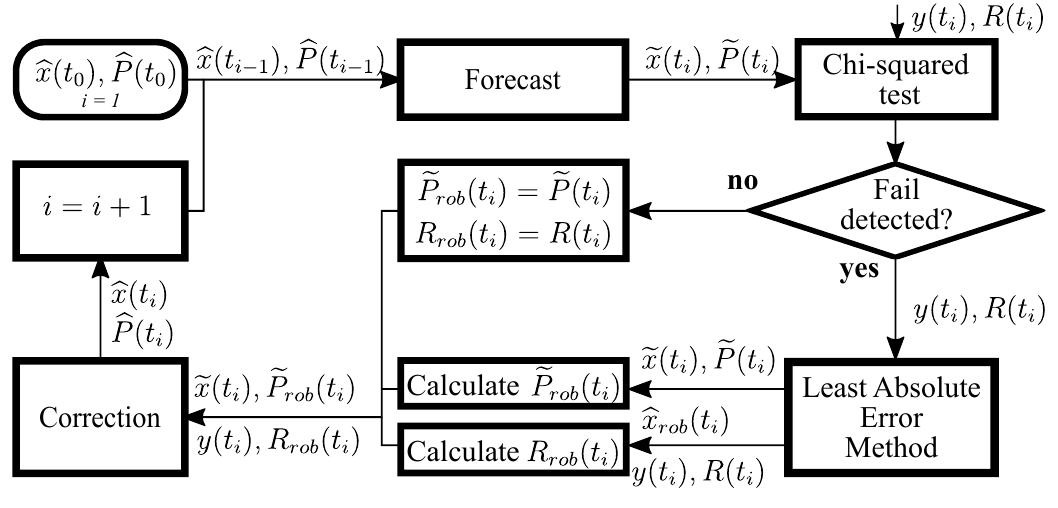
Figure 3. Robust Algorithm